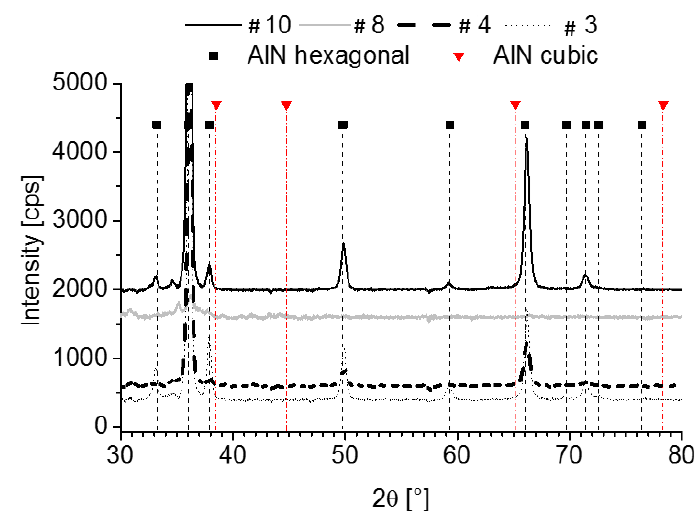
Figure 7. XRD plots of layers deposited on ceramic at an N 2 /Ar ratio of 10%.